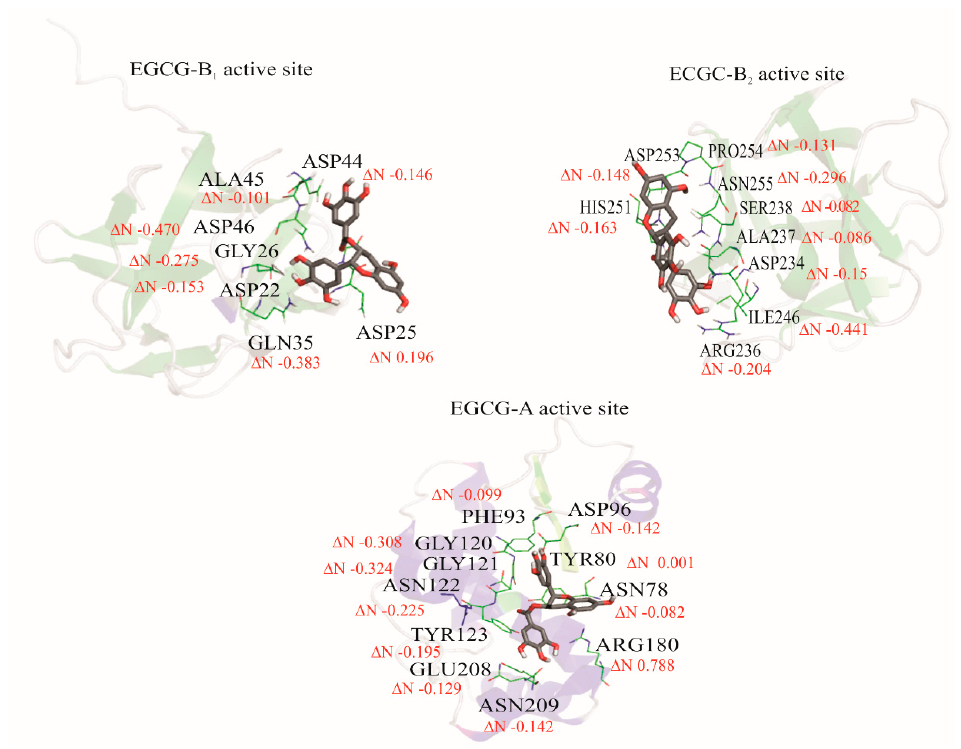
Figure 10. The schematization of the fractional number of transferred electrons ( Δ N) between epigallocatechin gallate and A, B 1 , and B 2 active sites of the ricin protein.